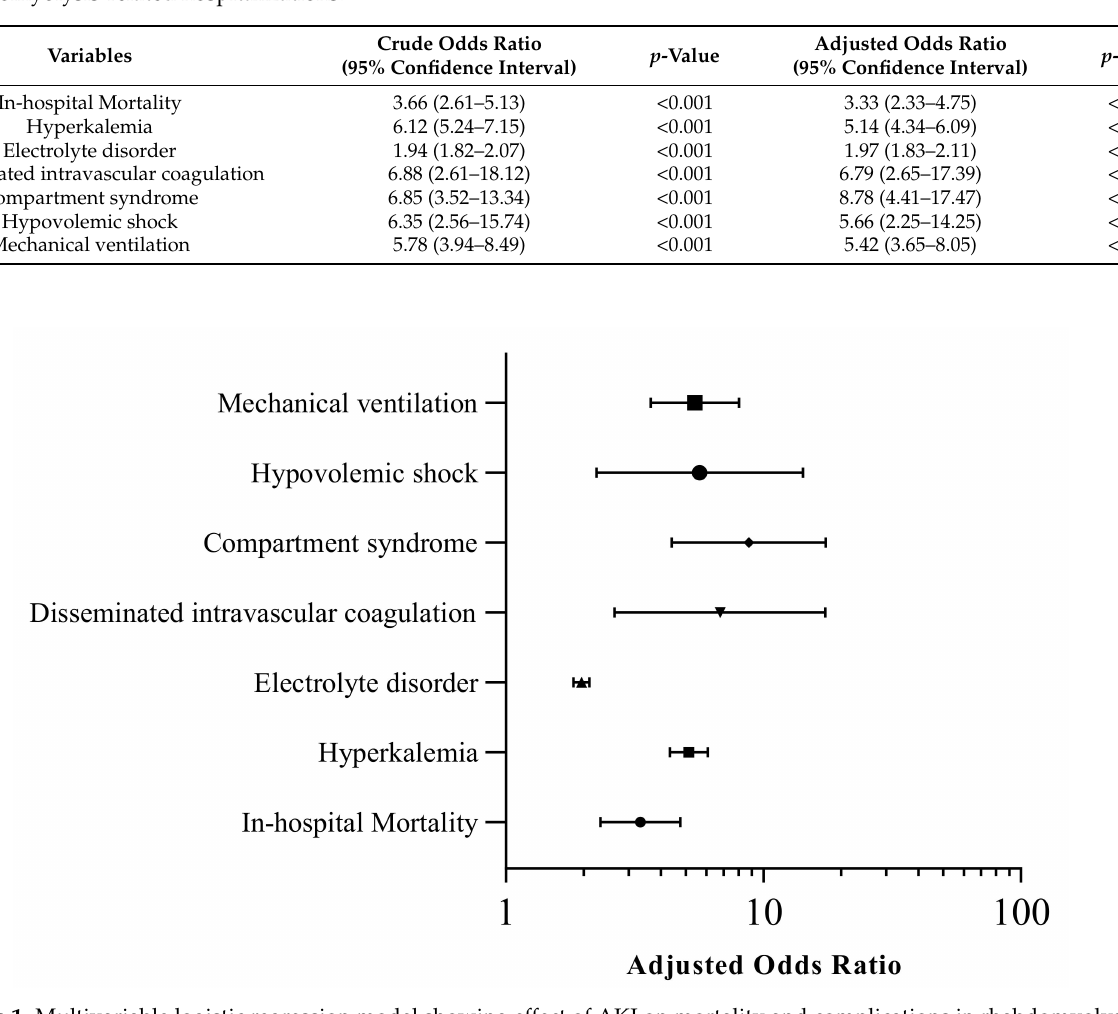
Table 2. Univariate and multivariable logistic regression model showing effect of AKI on mortality and complications in rhabdomyolysis-related hospitalizations.